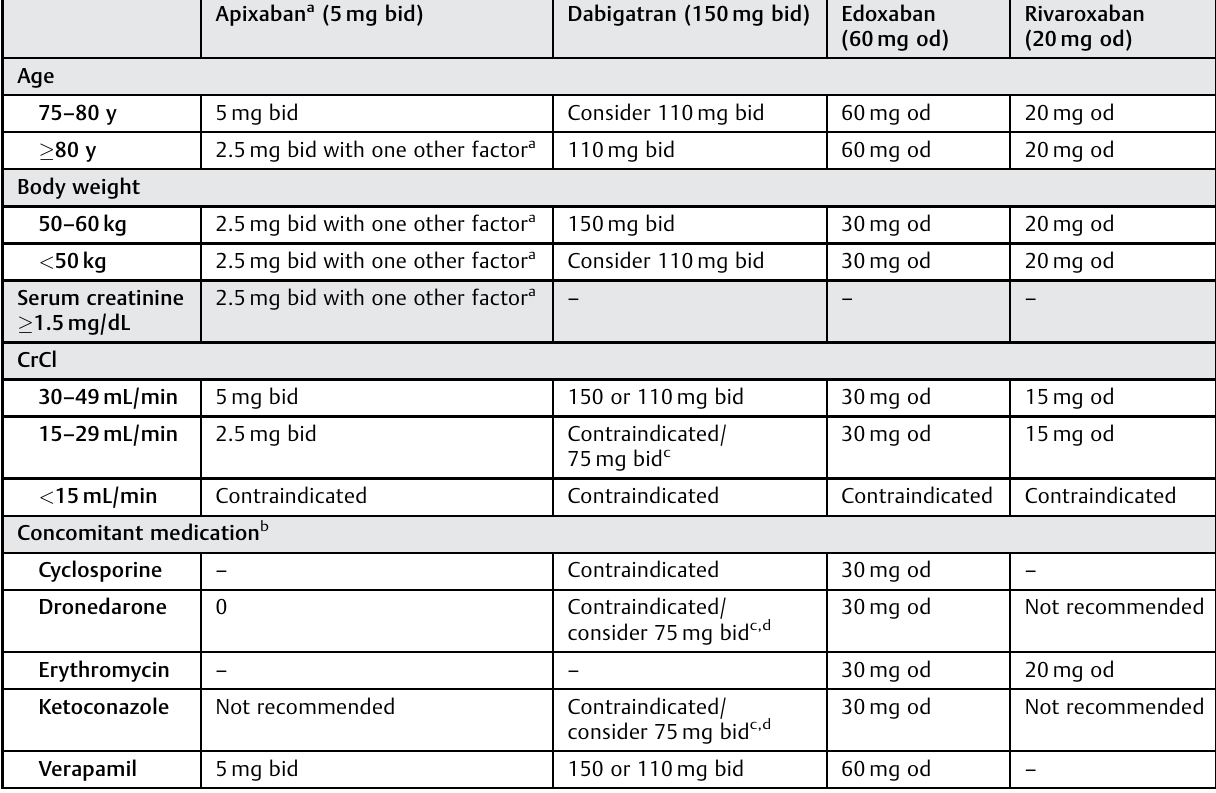
Apixaban a (5 mg